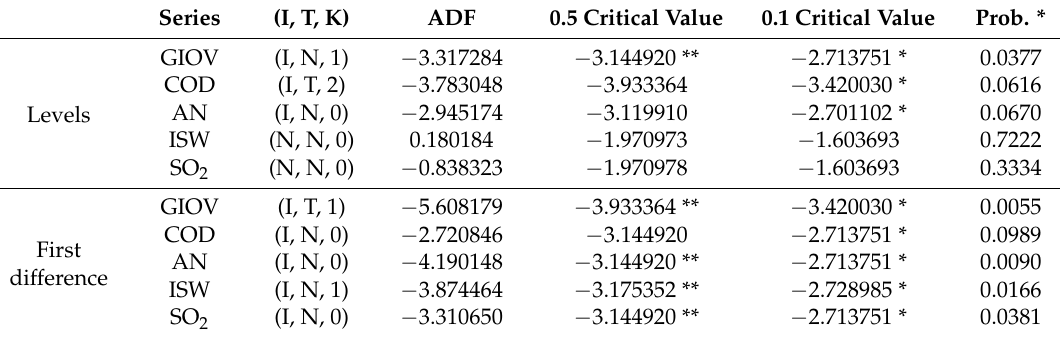
Table 5. Unit root test results for ferrous metal ore mining and processing.